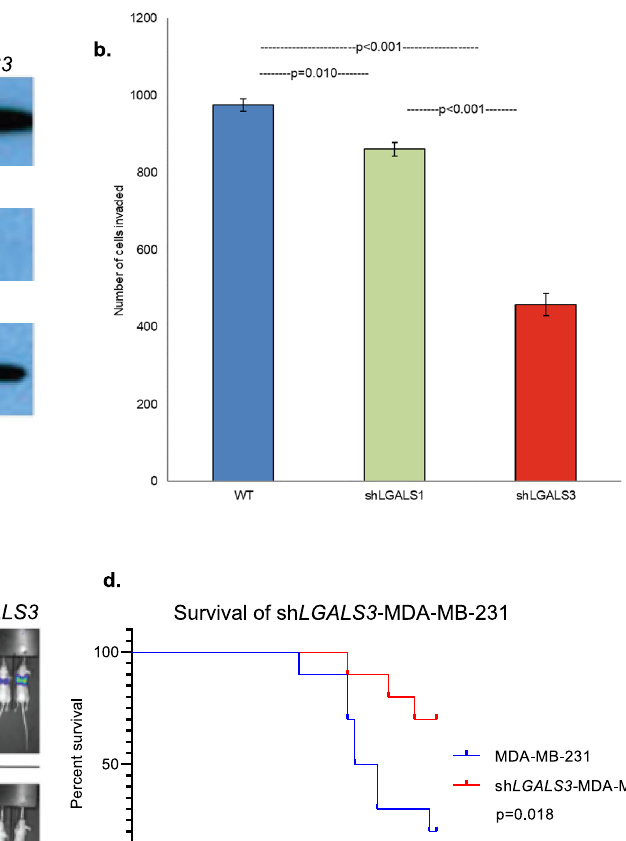
erating 14D11 antibody included two amino acids, N174 and E184, which form hydrogen bonds with LacNAc,